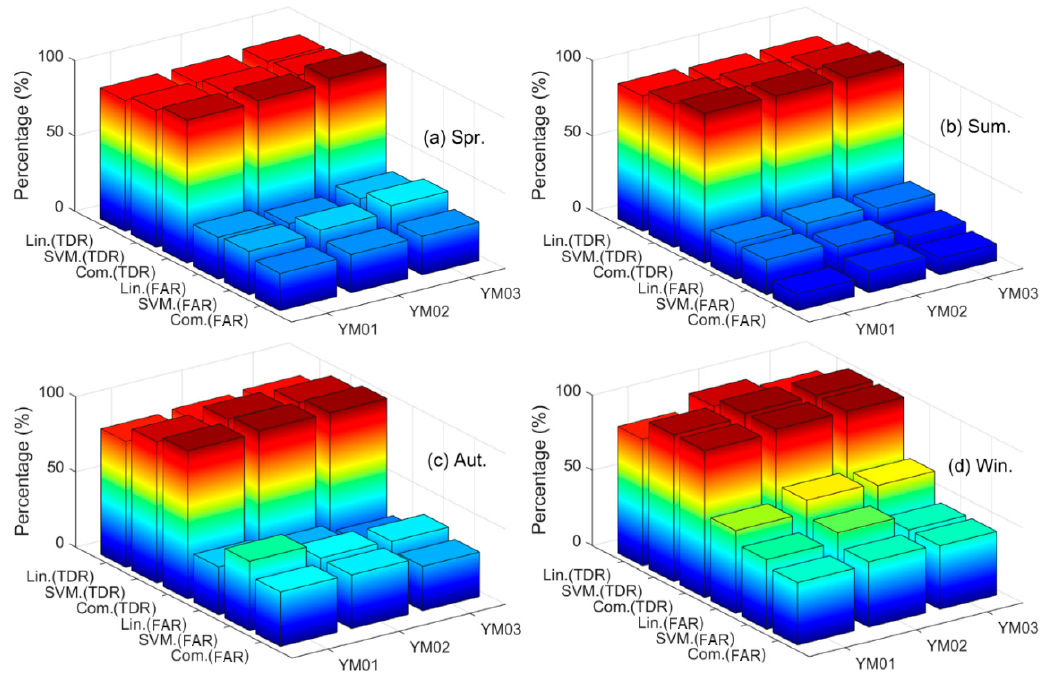
Figure 7. Statistical comparison of TDRs and FARs of three different methods by season during 2019–2020 at the three stations. Lin. represents the traditional linear method, SVM. represents the nonlinear method, and Com. represents the combined method proposed in this paper. Table 5. Statistical results of TDRs and FARs of the three rainfall forecast models (%).